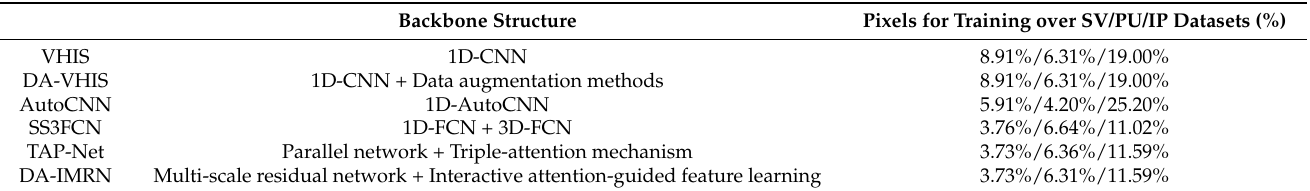
Table 2. The backbone structures and the dataset partitioning of state-of-the-art HSI classifica- tion methods.